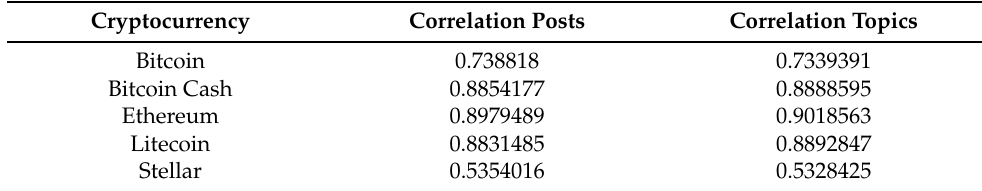
Table 7. Classification of correlation between closing value and data from Bitcointalk